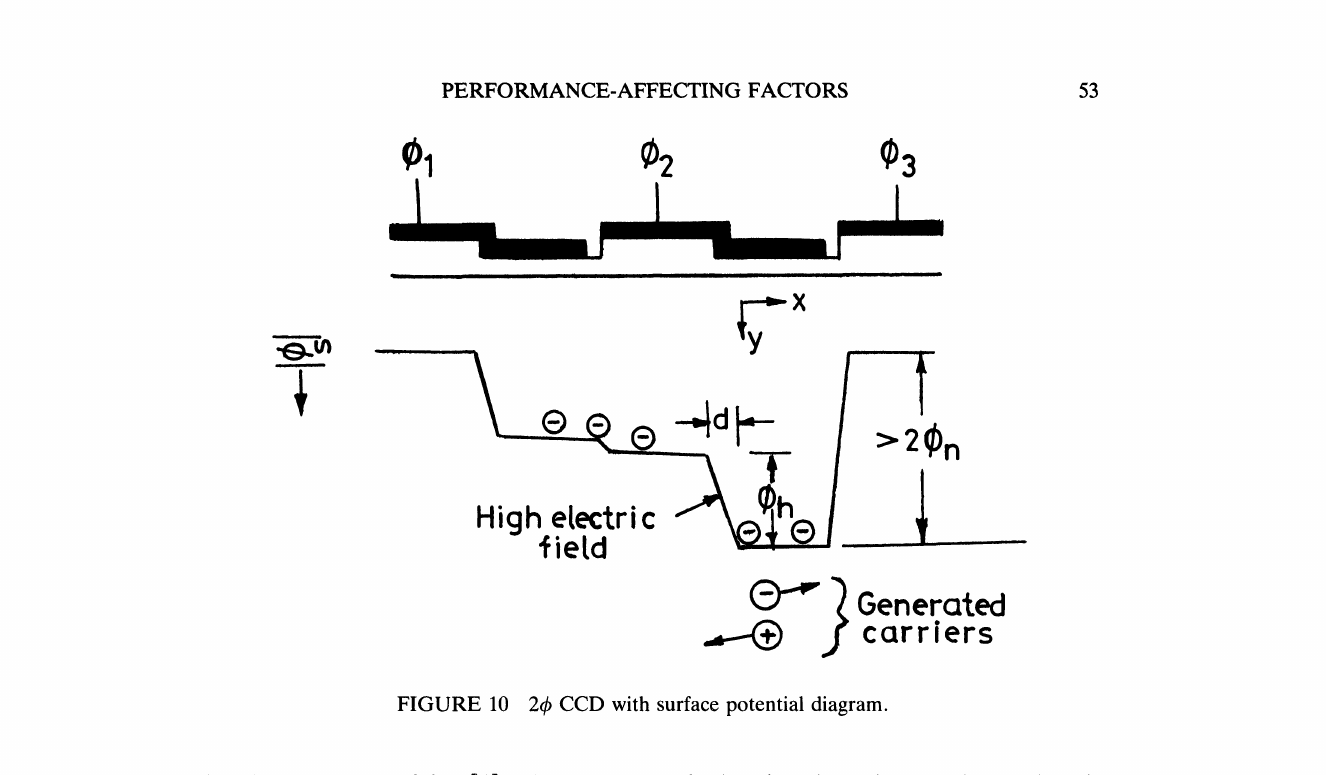
FIGURE 10 2b CCD with surface potential